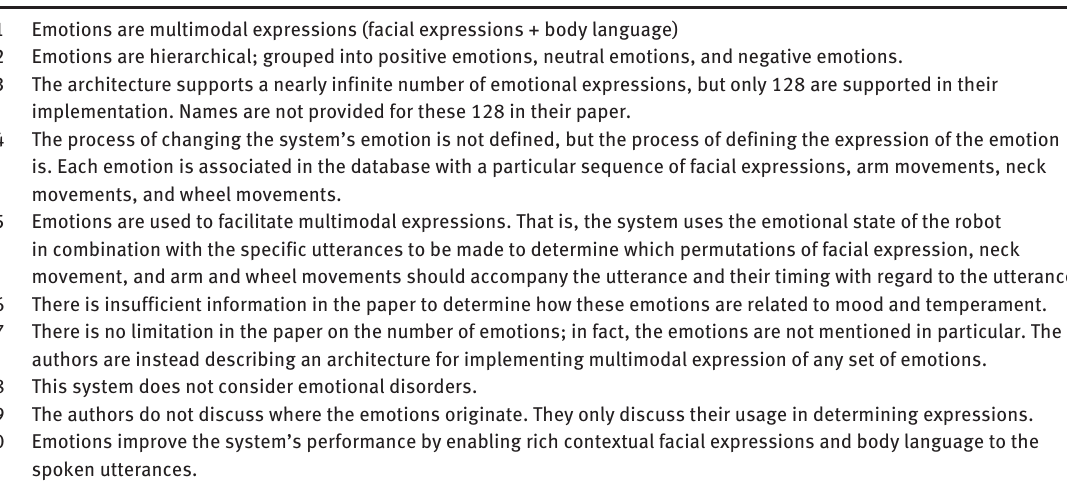
Table 15. Classification of Silbot